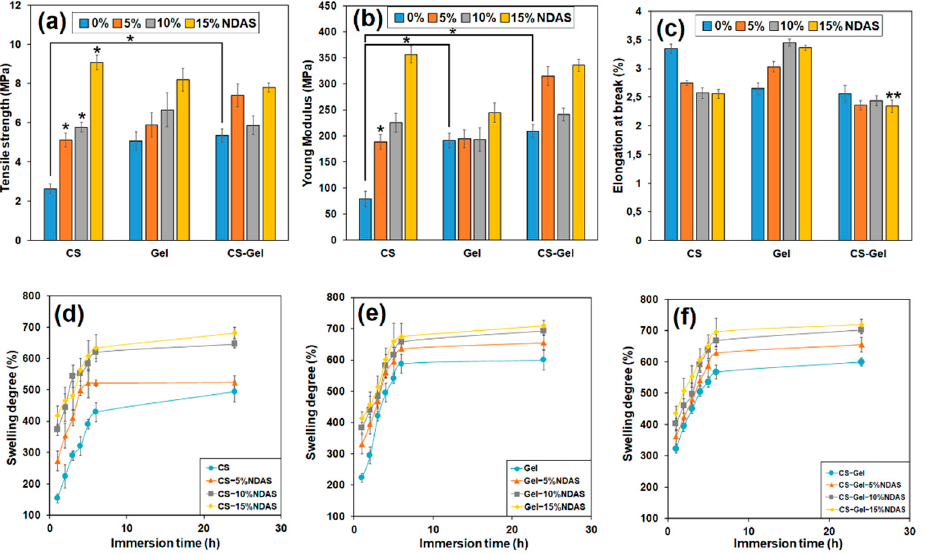
Figure 7. The value of ( a ) tensile strength, ( b ) Young’s modulus, and ( c ) elongation at break of chitosan (CS), gelatin (Gel), and chitosan–gelatin (CS-Gel) cross-linked by 5%, 10%, and 15% cross-linking agent; statistical significance is indicated with asterisks: * p < 0.05, ** p < 0.01. The swelling degree of ( d ) chitosan, ( e ) gelatin, and ( f ) chitosan–gelatin cross-linked by 5%, 10%, and 15% cross-linker (NDASs).